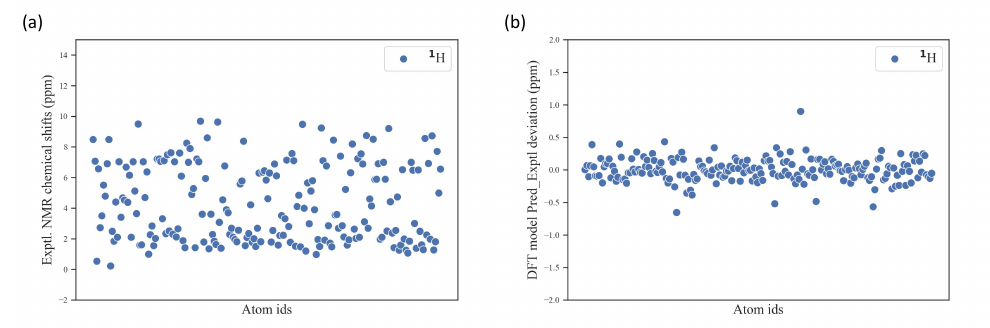
Figure 3. ( a ) Distribution of experimental NMR 13 C chemical shifts. ( b ) Distribution of the difference between the predicted and experimental 1 H NMR chemical shifts.